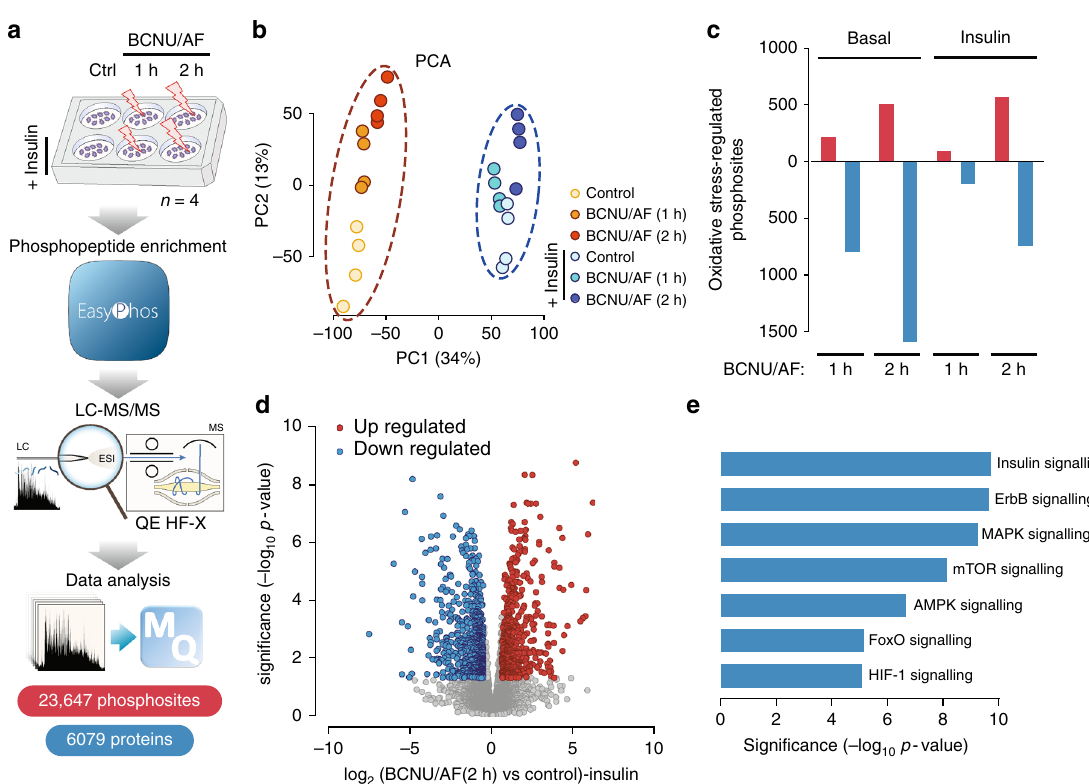
Fig. 2 Oxidative stress-regulated phosphoproteome in adipocytes. a Experimental design of the phosphoproteomic analysis of insulin- and BCNU/AF- treated adipocytes. b Principal component analysis of the phosphoproteome. c Summary of oxidative stress-regulated phosphoproteome in adipocytes with or without insulin treatment. d Volcano plot showing oxidative stress-regulated phosphoproteome in adipocytes with 2 h BCNU/AF treatment in the presence of insulin. Signi fi cantly regulated phosphosites (by moderated t -test from limma R package) were indicated in red (up-regulated) or blue (down- regulated, adjusted p < 0.05 and absolute fold change > 1.5). e Gene ontology over-representation analysis (Fischer ’ s exact test) of signi fi cantly oxidative stress-regulated phosphoproteins with 2 h BCNU/AF treatment in the absence of